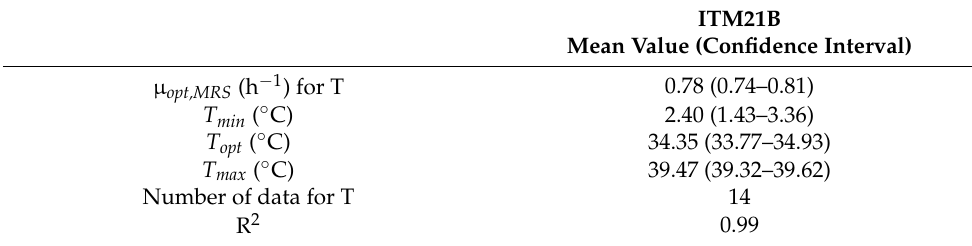
Figure 1. Effect of temperature ( T ) ( A ), pH ( B ), a w ( C ), and undissociated lactic acid [ HA ] concentra- tion at pH 4.7 (straight line) and pH 5.1 (dashed line) ( D ) on the maximum specific growth rate ( µ max ) of the L. plantarum ITM21B strain. Comparison between the fitted model and observed maximum specific growth rates ( (cid:4) ,o). Table 2. Estimated growth cardinal parameters for temperature ( T ), pH , water activity ( a w ), and minimum inhibitory concentration of undissociated lactic acid ( MIC U ) and 95% confidence interval for the L. plantarum ITM21B in modified